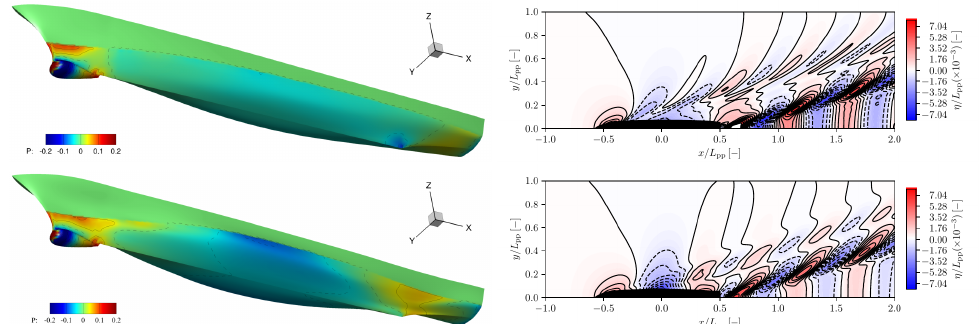
Figure 9. Pressure on hull ( left ) and free-surface elevation ( right ) of the original ( top ) and MF-CS-DF (DtSr) optimum ( bottom